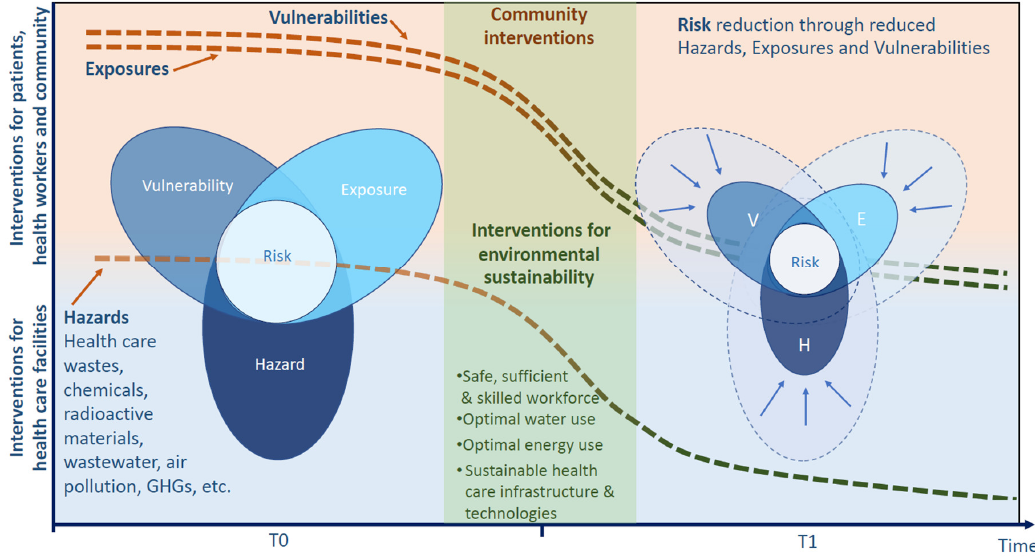
Figure 2. Environmental sustainability in health care facilities.